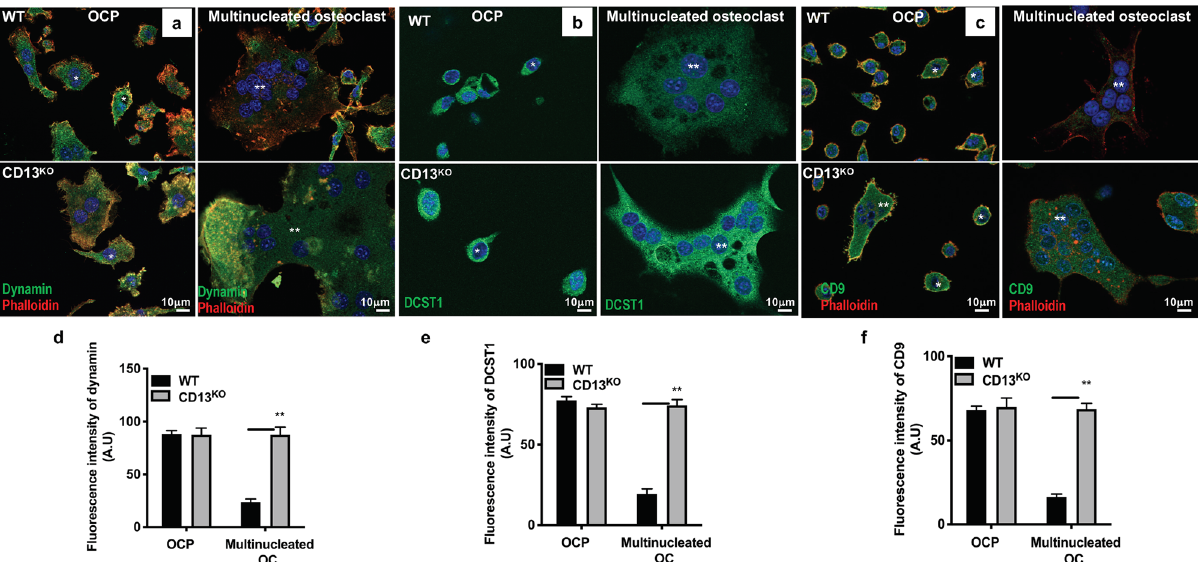
Figure 6. Immunofluorescence analysis of persistent expression of fusion-regulatory proteins in CD13- deficient multinucleated OC. Expression of the fusion regulatory proteins dynamin ( a , d ), DCST1 ( b , e ) and CD9 ( c , f ) is maintained in CD13 KO multinucleated osteoclasts but not in WT cells (**). High levels of dynamin co-localize with actin and DCST1 in OCPs (*), imaged using Zeiss LSM 880 confocal fluorescence microscope and analyzed by Zeiss Zen 2.0 Pro blue edition software (https:// www. zeiss. com/ conte nt/ dam/ Micro scopy/ Downl oads/ Pdf/ FAQs/ zen2- blue- editi on_ insta llati on- guide. pdf). Scale bar; 10 µm. Data represents average of three independent experiments. N = 3/genotype. Dynamin, CD9, DCST1; green. Phalloidin; red. Magnification ×63